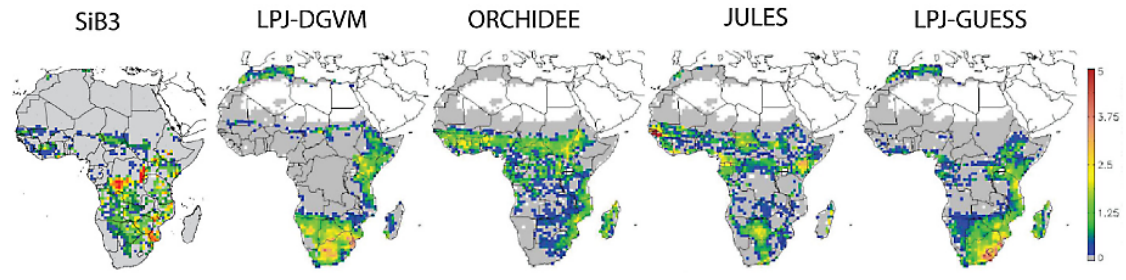
− IAV , from five σ IAV